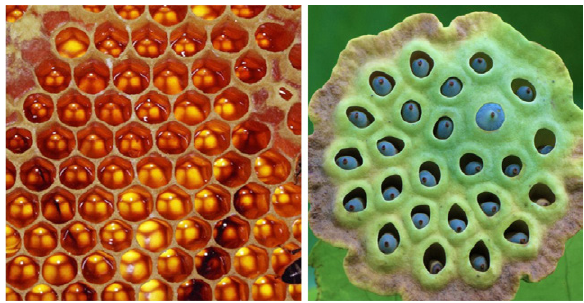
Figure 2. The honeycomb and the lotus seed pod